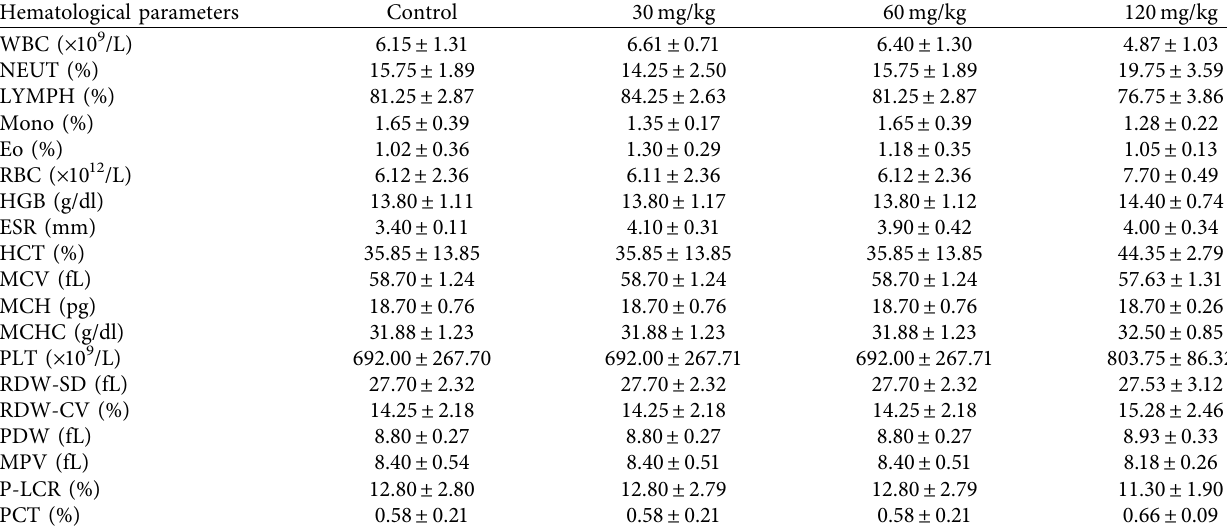
Table 3: The effects of goose bone on the hematological parameters in whole blood. Hematological parameters